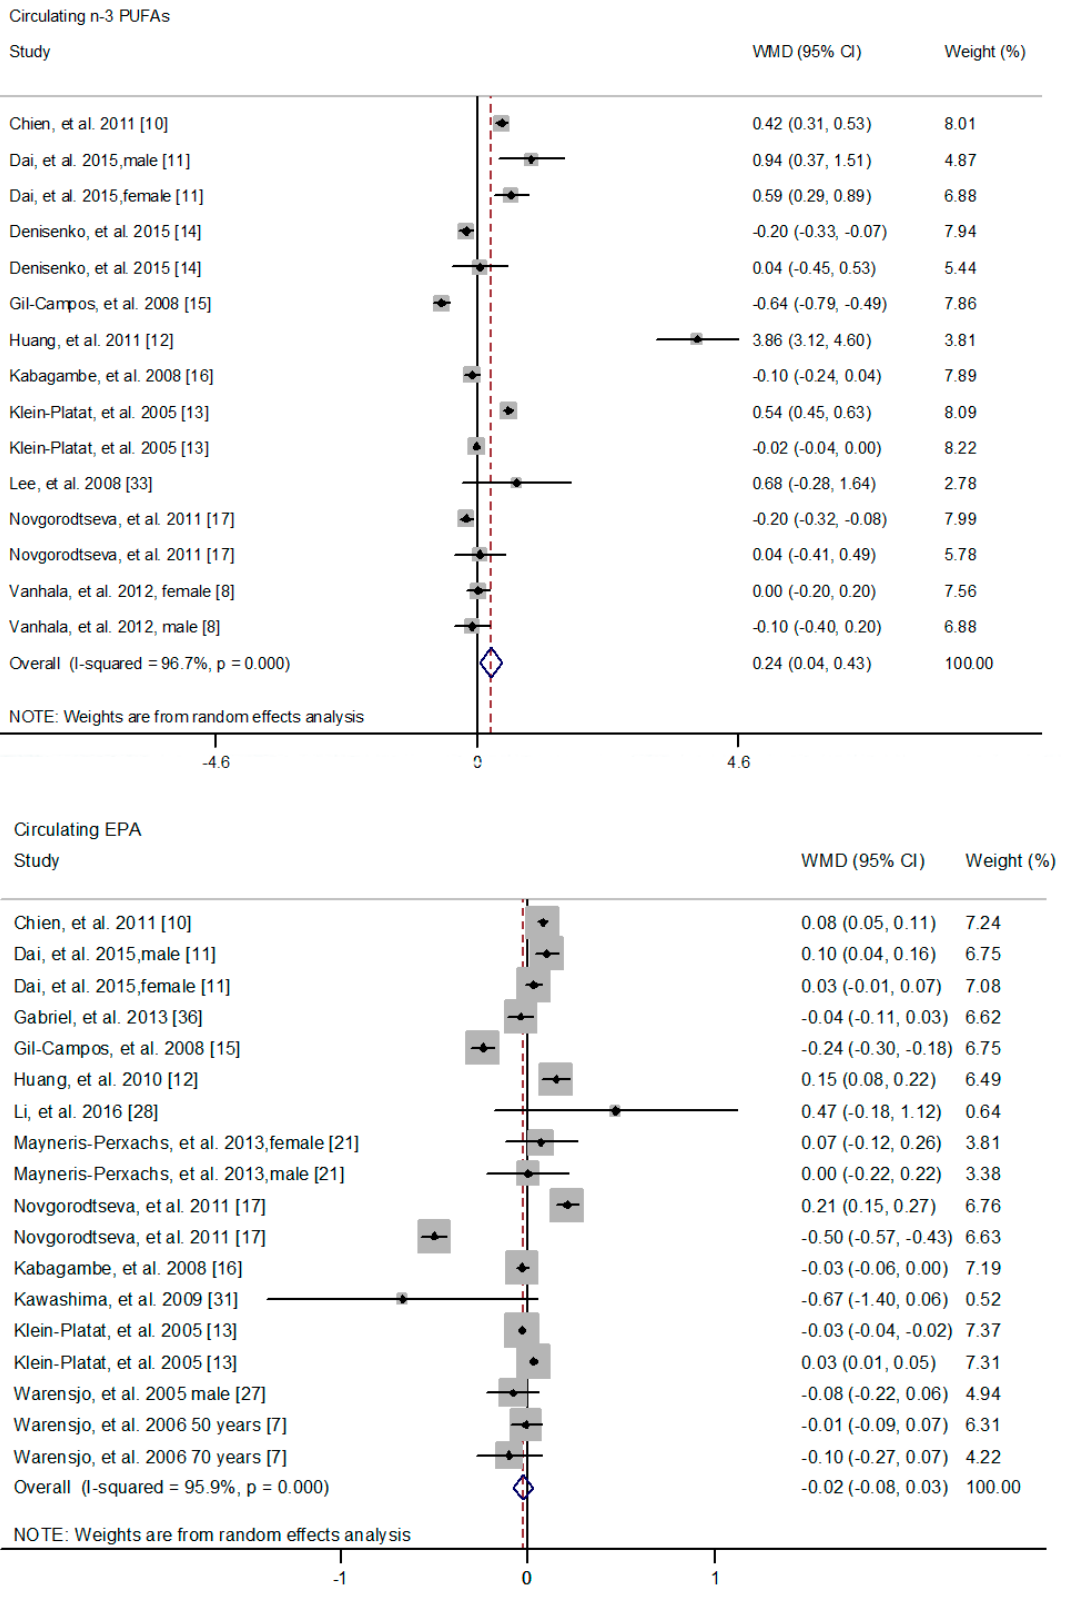
Figure 4. Differences of circulating n -3 PUFAs or EPA composition between cases and controls. The pooled effect was calculated by using a random-effects model. The diamonds denote summary risk estimate, and horizontal lines represent 95% CI. Abbreviations: EPA, eicosapentaenoic acid; PUFA, polyunsaturated fatty acid